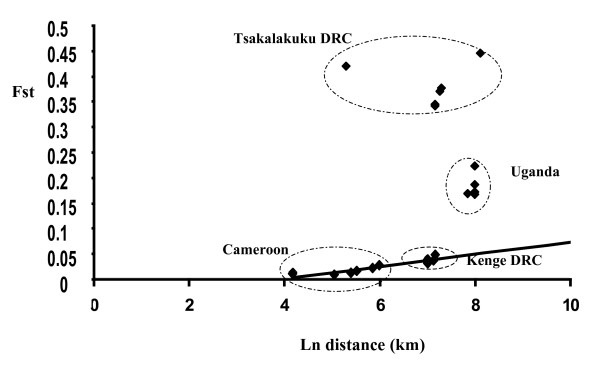
Correlation between average Fst estimates over 10 microsatellite loci and logarithm of geographic distance between collection sites for pairwise comparisons of seven A. moucheti populations from Cameroon, DRC and Uganda. The name of each sampling site refers to comparisons involving these populations.